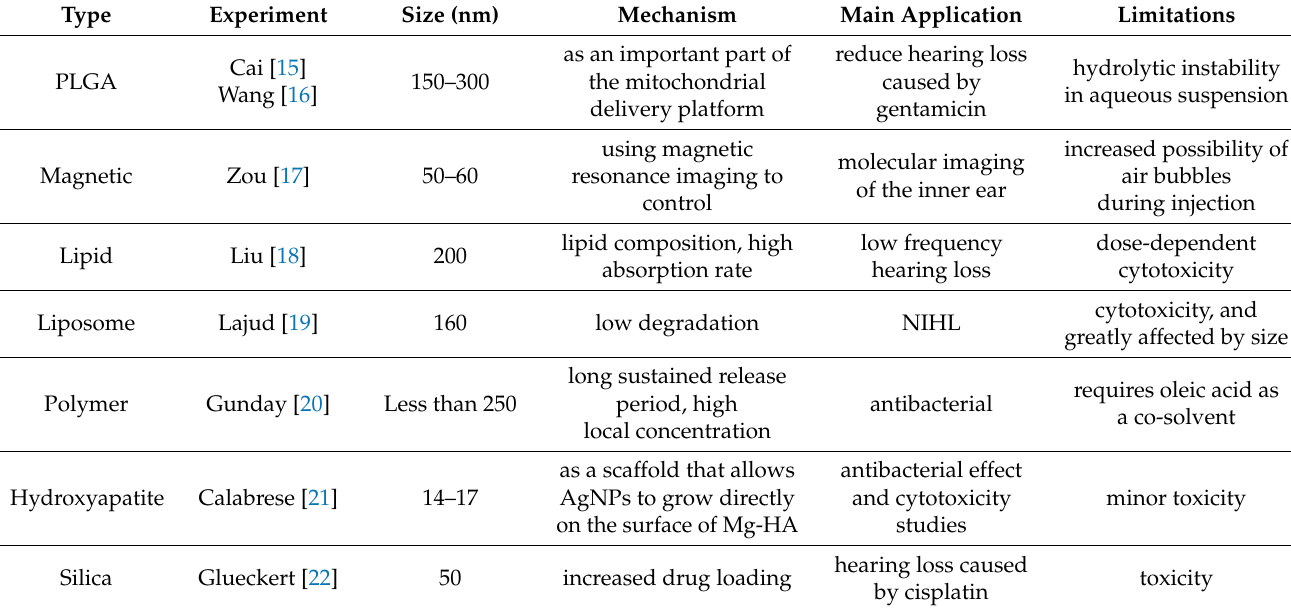
Table 3. The main types of nanoparticles delivered by the inner